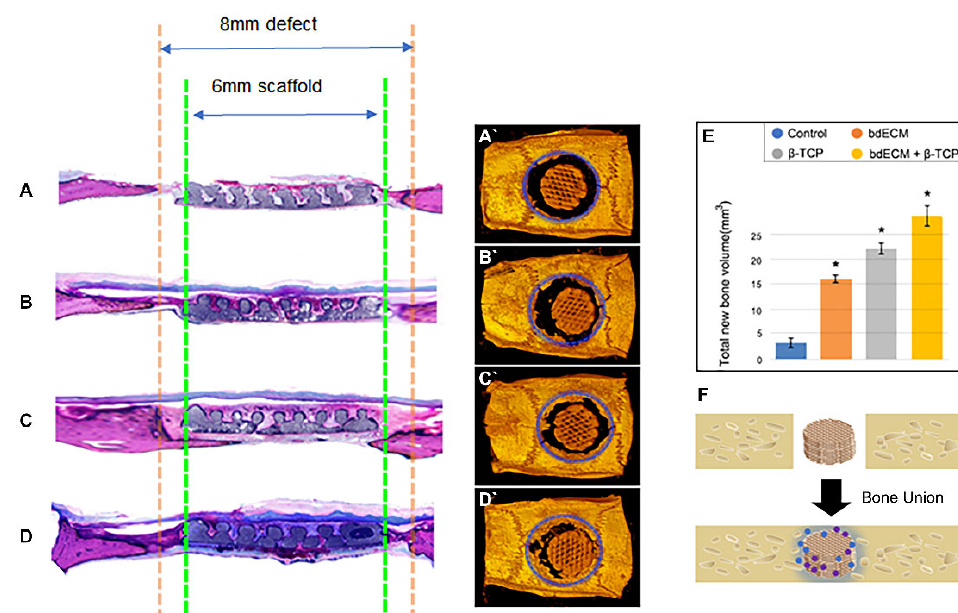
Figure 3. Masson’s trichrome staining and computed tomographic scan. ( A – D ). Green line indicate scaffold boundary and orange line indicate bone defect. Soft tissues were observed in all groups (red staining), blue staining that indicates newly formed bone tissue was observed in the group of bdECM + β -TCP; ( A‘ – D‘ ). Blue dotted line indicates calvarial defect edge, and the bone area inside the blue dotted line is the new bone. According to CT images, the new bone volume in the group of bdECM + β -TCP increased compared to other groups. Blue arrow indicates newly formed bone originated from host bone tissue and black arrow indicates bone union of scaffold and host bone tissue( D‘ ); ( E ). All data were expressed as mean ± standard deviation and asterisk indicates statistical significance ( p < 0.05) compared to control; ( F ). Schematic illustration of bone union between host and graft by bdECM and β‐ TCP.